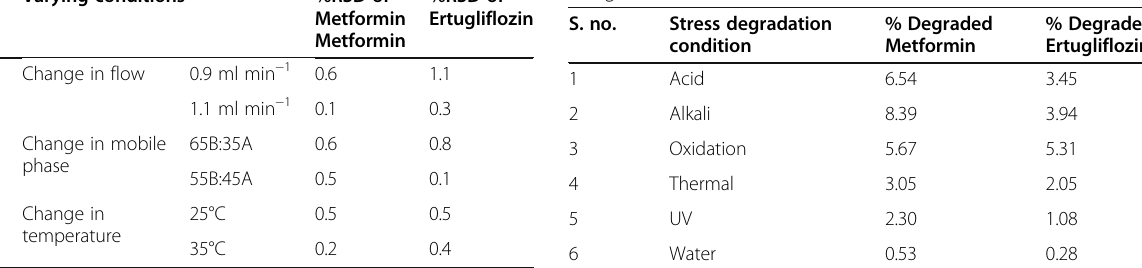
Table 7 Results of forced degradation study of Metformin and